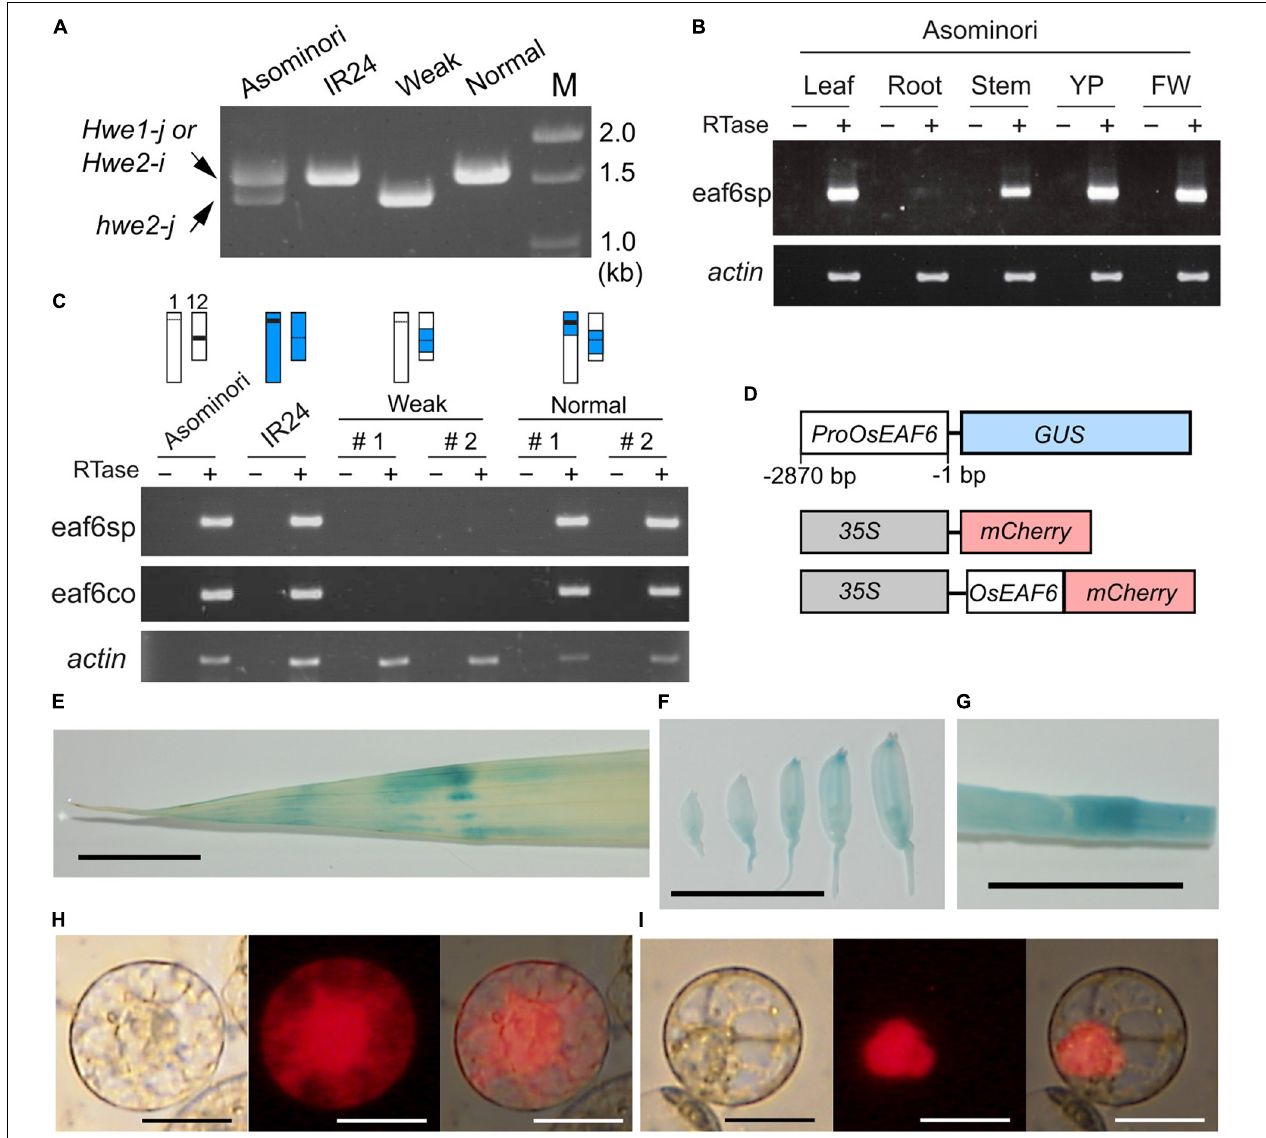
FIGURE 3 | Expression pattern and cellular localization of the OsEAF6. (A) Amplified genomic DNA product obtained with the primer eaf6co. The expected sizes of DNA bands were 1,557 bp from Hwe1-j and Hwe2-i and 1,352 bp from hwe2-j. The primer eaf6co was designed for the identical sequence region between Hwe1-j (functional gene) and hwe2-j (pseudogene). It is noted that the eaf6co primer could amplify the product from genomic DNA but not from mRNA, as shown in (C) . (B) mRNA expression of OsEAF6 in rice tissues detected using RT-PCR analysis. eaf6sp is a primer set specific to functional OsEAF6 [ japonica Hwe1 ( Hwe1-j ) allele and indica Hwe2 ( Hwe2-i ) allele] but not the pseudogene on the hwe2-j allele. YP, young panicle; FW, flowering panicles (C) mRNA expression of OsEAF6 in the NILs and parents with the two different primer sets by RT-PCR analysis. Genotype of each sample for chromosomes 1 and 12 is shown on the upper part. White and blue bars represent Asominori and IR24 chromosomes, respectively. Two individuals for the weak and normal plants (#1 and 2) are shown. (D) Diagram of constructs designed for expression analysis of OsEAF6. (E–G) GUS expression analysis of OsEAF6 by using ProOsEAF6:GUS expresser in leaf (E) , developing flowers (F) , and stem (G) tissues. (H,I) Subcellular localization of OsEAF6 protein fused with mCherry (I) and mCherry alone (H) in rice protoplast cells. Transient expression of each fluorescent construct was observed. Left, DIC image; middle, mCherry channel image; right, merged image. Scale bar = 1.0 cm in (E–G) , and 20 µ m in (H–I)